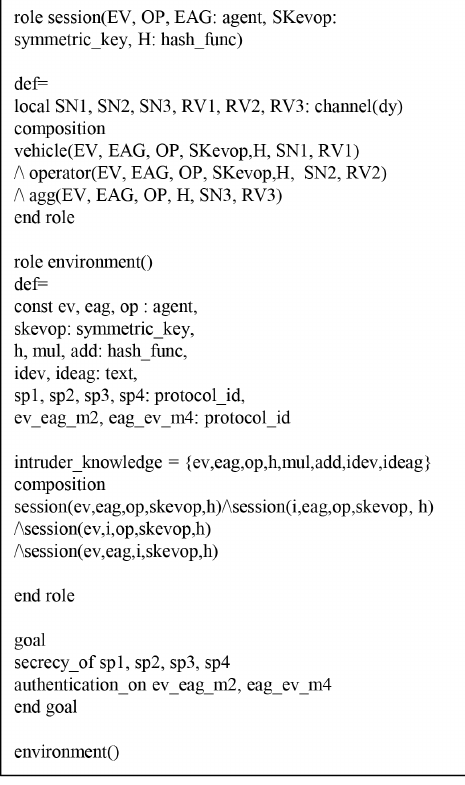
Figure 12. Specification of the session.